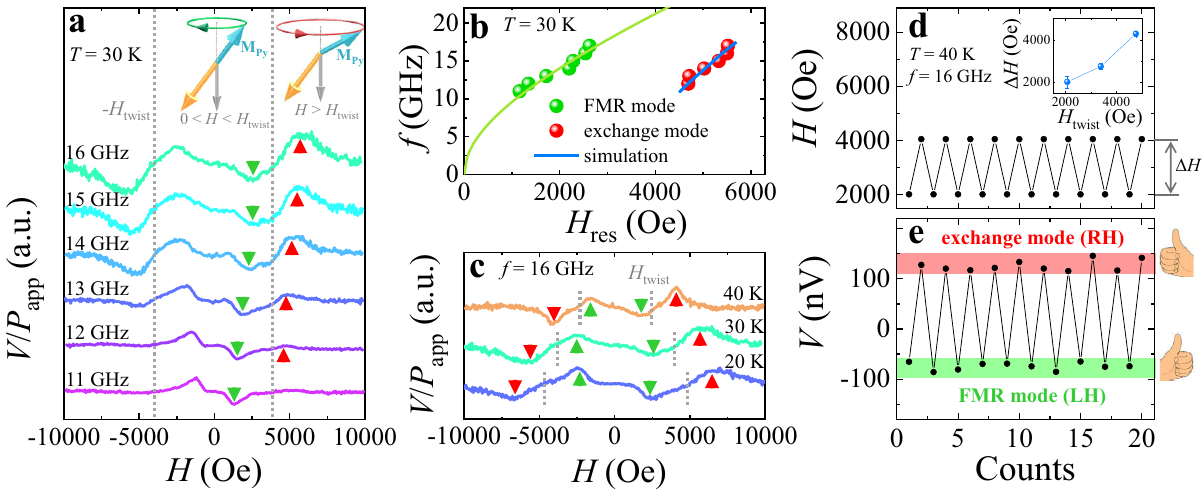
( θ Py = 0° and θ H = 180°). As shown in Fig. 4a, negative V ( H ) is observed when H < H twist (green arrows), which corresponds to the left-handed M Py precession of the FMR mode (con fi rmed via fi tting by the Kittel equation in Fig. 4b. A positive V ( H ) (red arrows) emerges in the twisted state ( H > H twist ) when f exceeds 12 GHz, corresponding to the second resonance mode 24 . This of M Py and M Gd in the twisted state. The positive V ( H ) of this mode indicates the right-handed M Py precession, which is con- fi rmed via micromagnetic simulation 38 (Supplementary Note 6).